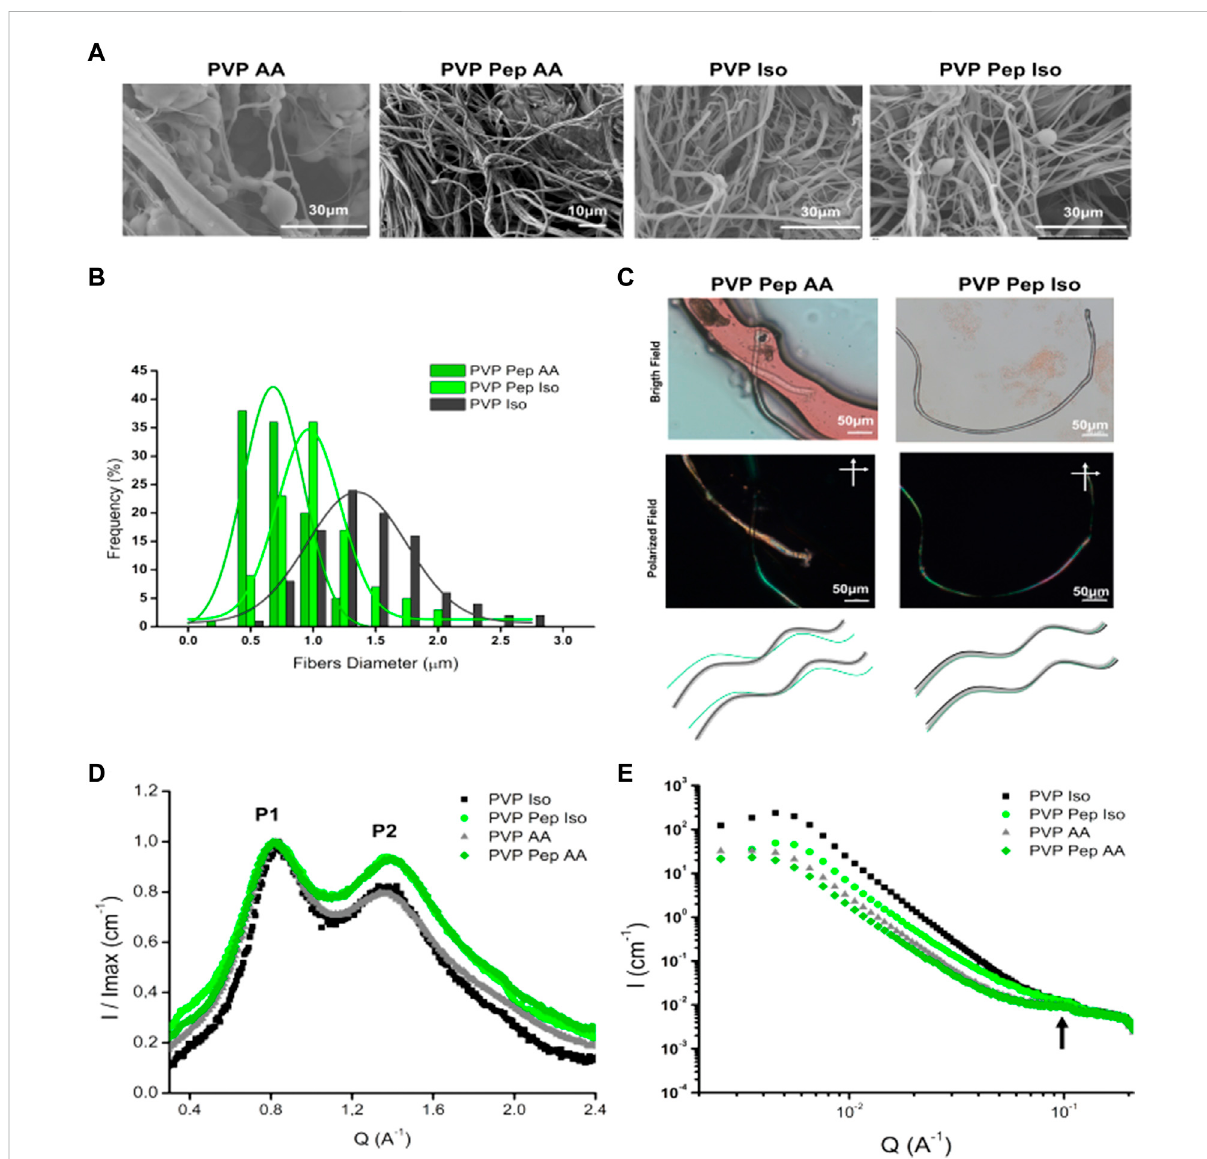
FIGURE 2 Characterizationofpolymerandpeptide fi bersproducedbySolutionBlowSpinning. (A) SEManalysisof fi bersproducedin80%AceticAcid(AA) and 70% isopropanol (Iso). It was observed several defects in PVP AA fi bers and all the other samples present fi bers without defects. (B) Histogram of the fi bersdiameter for samples:PVP PepAA, PVP PepIso and PVP Iso. (C) In theupperpanel, microscopic observation ofCongored stainingfor PVP Pep AA and PVP PepIso fi bers. In PVP PepAA, in bright fi eld are observed two fi bers: one main fi ber in red and a second thinner fi ber, but under polarized fi eld (cross polarized at 90 ° angle) only the thinner fi ber presents green birefringence. In PVP Pep Iso, only one fi ber is observed in bright fi eldandinpolarized fi eldhasareaswithgreenbirefringence.Inthelowerpanel,schematicofthemicroscopicobservations,forthePVPwithpeptide fi bersobtained inthedifferentsolvents: amain fi ber ofPVP (black), apeptide fi ber(green) and a fi ber that containbothcompounds (grey). (D) WAXS, the P1 and P2 identify two main peaks observed in the different fi bers. (E) SAXS data for the different fi bers, the arrow identi fi es a weak correlation